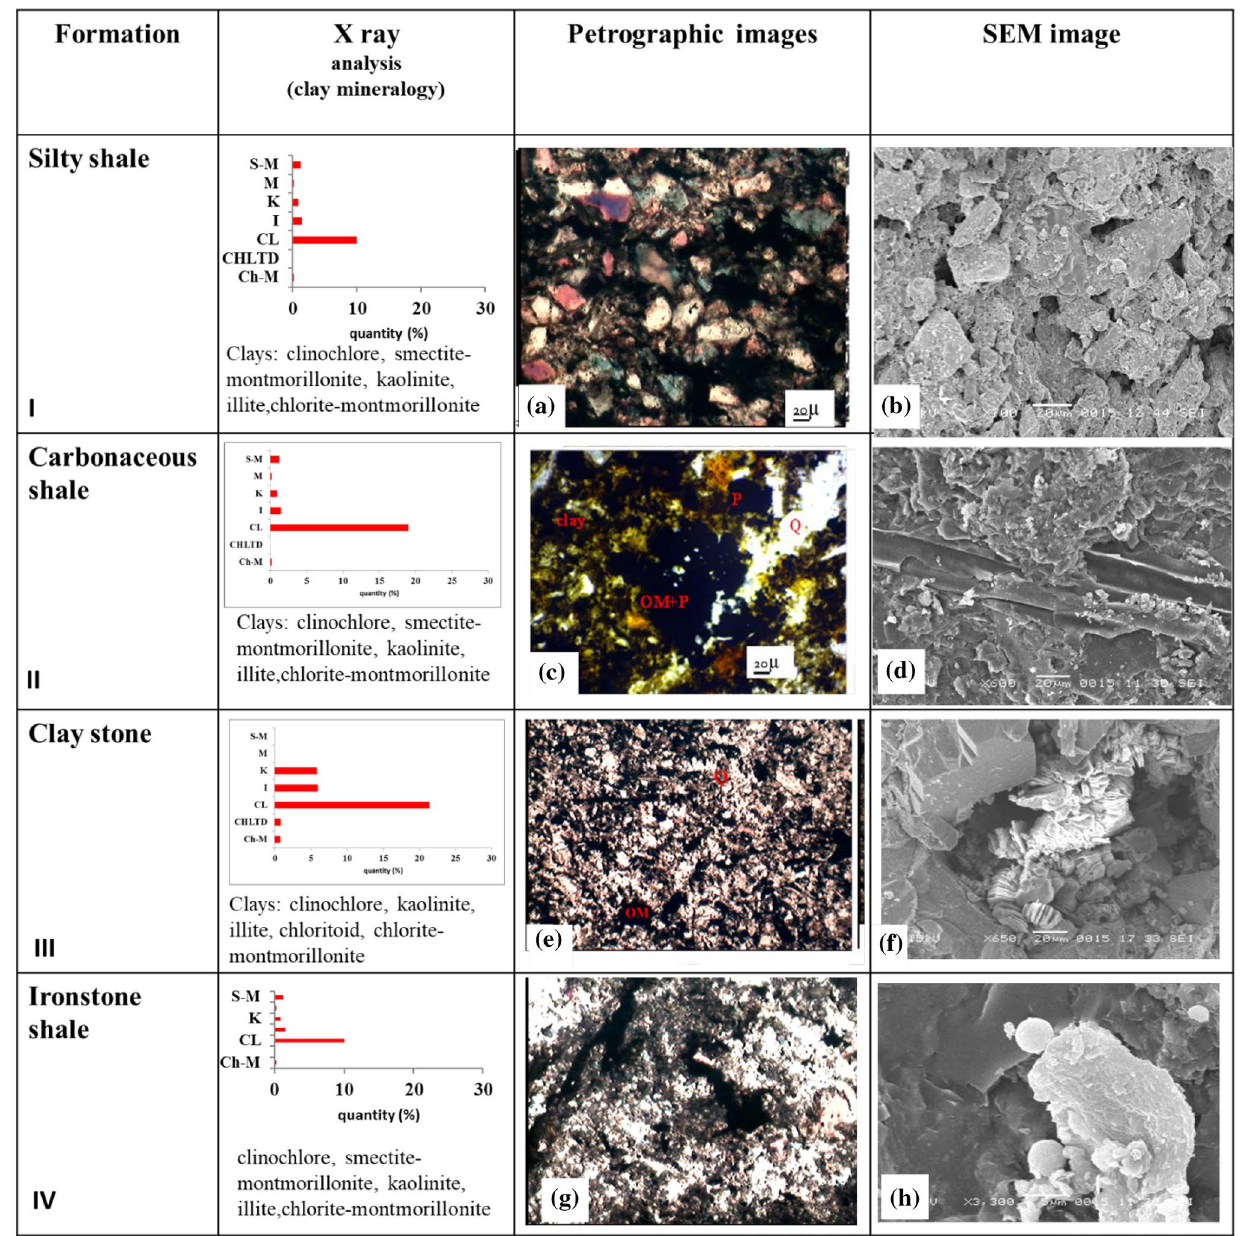
Fig. 4 Classification of lithofacies of Barren Measures shale based on mineralogy, petrography andscanning electron microscopy.